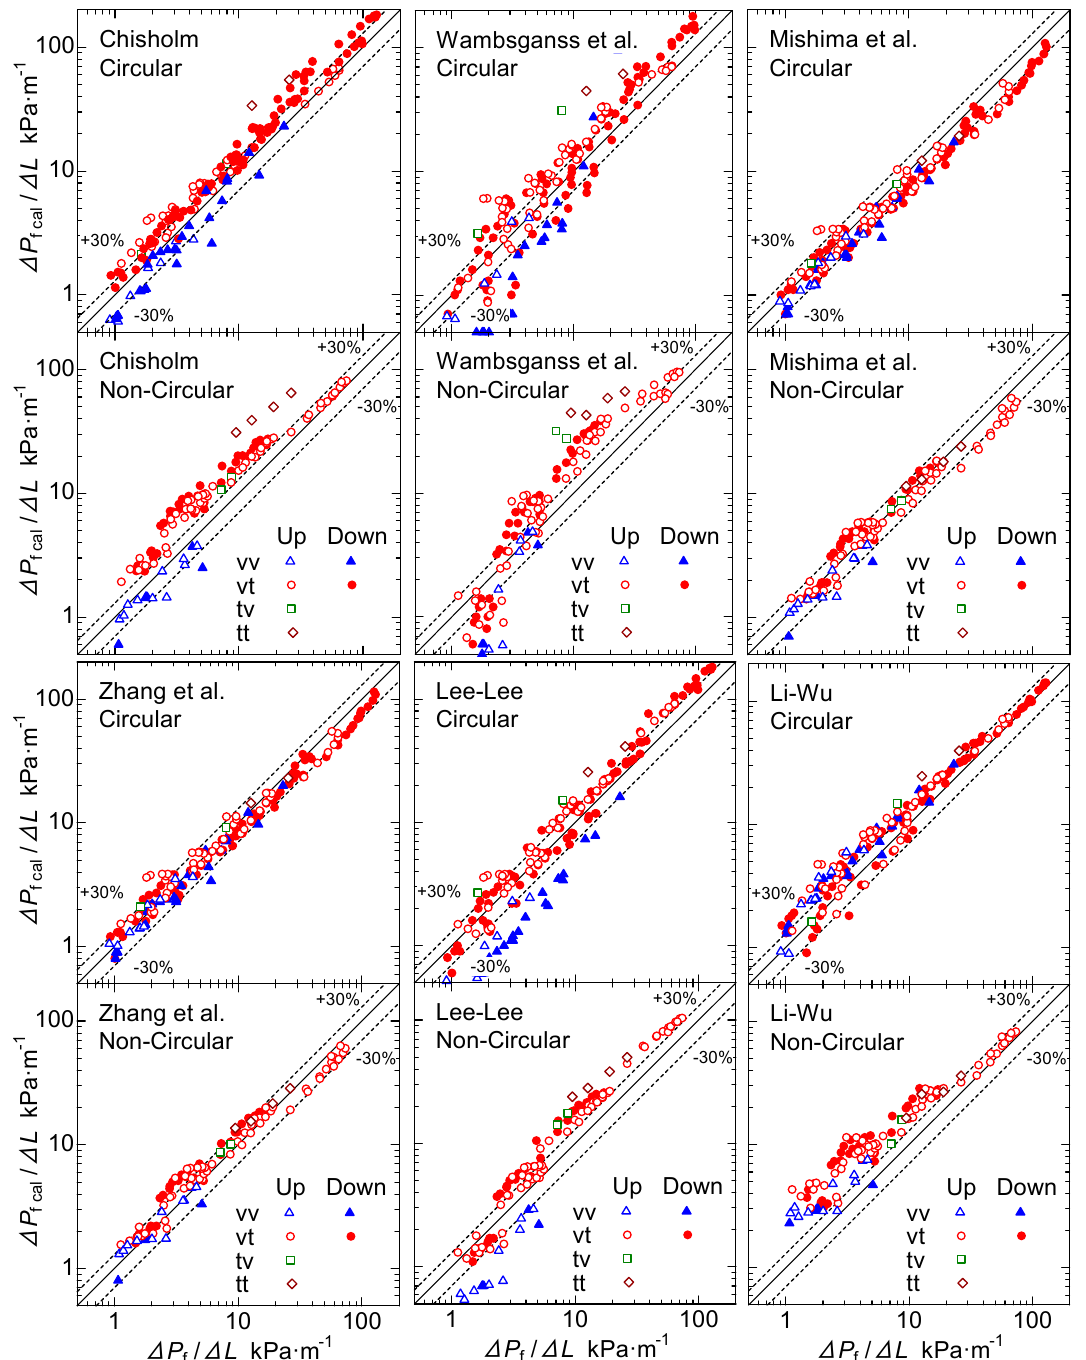
Figure 17. Comparison of calculated and measured frictional pressure drop gradients. The definition of the liquid limits or vapor Reynolds number Re L Re G between the laminar and turbulent is 2000. Of all 297 data points, 51 data points (17.2%) were laminar (liquid)–laminar (vapor); N = 236 data points (79.5%) were laminar (liquid)–turbulent (vapor); 4 data points (1.3%) were turbulent (liquid)–laminar (vapor); and 6 data points (2.0%) were turbulent (liquid)–turbulent (vapor). Wambsganss et al. noted that Equation (13) is applicable for Re L0 < 2200 and <1.0; however, at this time, all 297 data points are adapted.